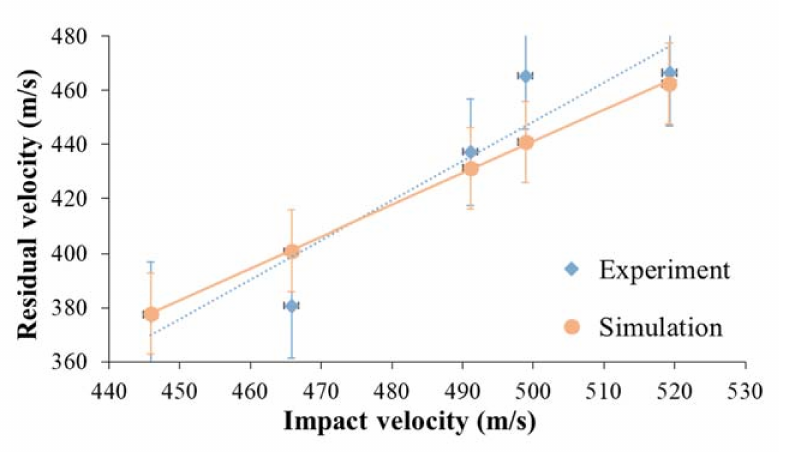
Figure 5. FE model validation against experimental results.